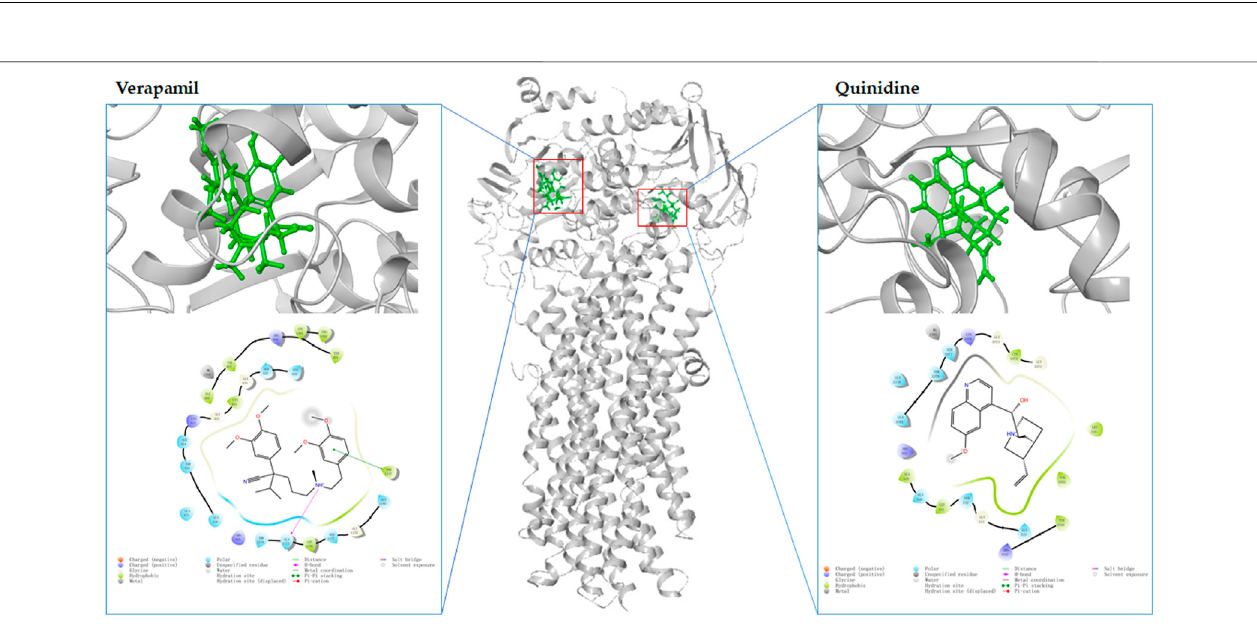
FIGURE 4 | The molecular docking of MDR1 (gray, PDB:6C0V) with verapamil (green left) and quinidine (green, right) by MAESTRO Schrödinger released in 2017-1.